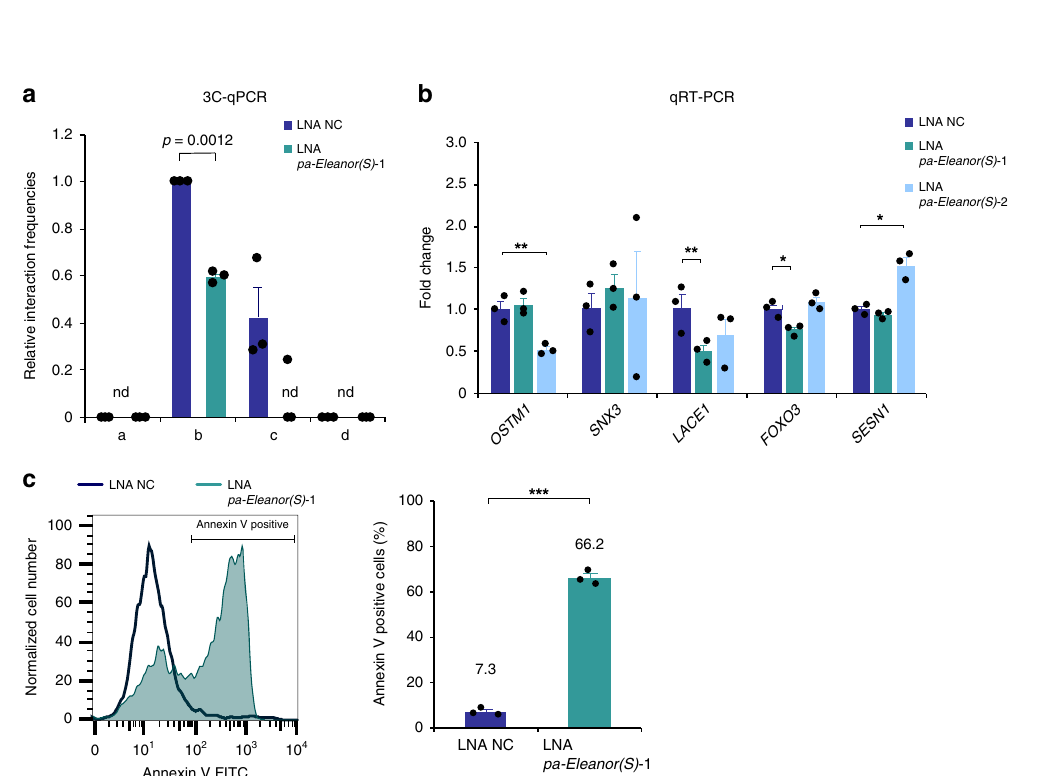
Fig. 6 Knockdown of pa-Eleanor(S) suppressed the long-range chromatin interaction without reducing FOXO3 gene activity and induced apoptosis in long- term estrogen deprivation (LTED) cells. a 3C-qPCR (chromosome conformation capture – quantitative polymerase chain reaction) analysis shows that pa- Eleanor(S) knockdown reduced interaction between ESR1 and b sites at 6q21 in LTED cells. Interaction frequencies were measured between the ESR1 promoter and indicated positions (a – d; thick blue bars in Fig. 2a). b Expression levels of genes around the Eleanor topologically associating domain with pa- Eleanor(S) knockdown in LTED cells. Quantitative reverse transcription polymerase chain reaction values of cells treated with Antisense LNA GapmeR for the negative control were set to 1. c Fluorescence-activated cell sorting (FACS) analysis of Annexin V-stained cells shows that knockdown of pa-Eleanor(S) increased apoptosis in LTED cells. A representative FACS pro fi le is on the left. Quanti fi cation of the FACS analysis is on the right. Data presented in a – c are representative of three independent experiments (mean ± s.e.m.). P values were calculated using unpaired, two-tailed, Student ’ s t test (* P < 0.05, ** P < 0.01, *** P < 0.001, n.d. = not detected in at least one